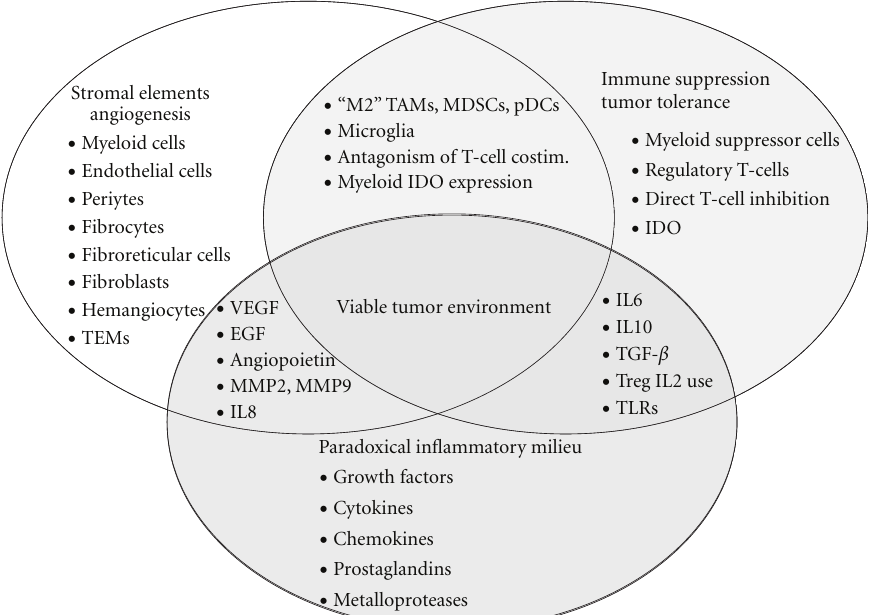
Figure 1: Viable tumor environment. Tumor survival is dependent upon an exquisite interplay between the critical functions of stromal development and angiogenesis, local immune suppression and tumor tolerance, and paradoxical inflammation. TEMs: TIE-2 expressing monocytes; “M2” TAMs: tolerogenic tumor-associated macrophages; MDSCs: myeloid-derived suppressor cells; pDCs: plasmacytoid dendritic cells; co-stim.: co-stimulation; IDO: indoleamine 2,3-dioxygenase; VEGF: vascular endothelial growth factor; EGF: epidermal growth factor; MMP: matrix metaloprotease; IL: interleukin; TGF- β : transforming growth factor-beta; TLRs: toll-like